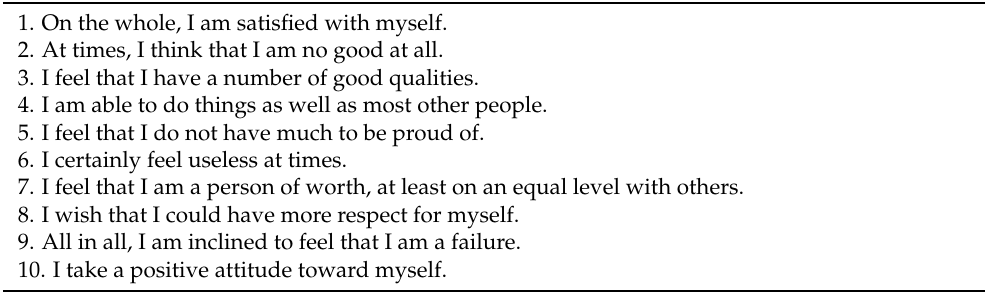
Table A1. Items of Rosenberg’s Self-Esteem